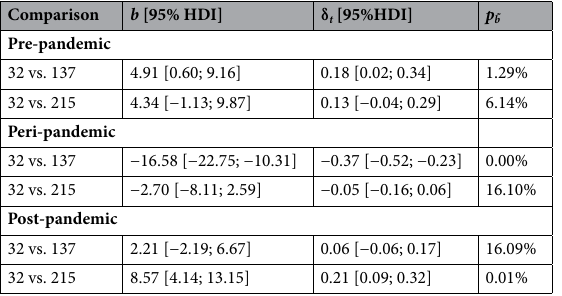
Table 1. Parameters of the Bayesian t -tests for the comparisons between the two follow-up dates and day 32, separate for each IPD measure; day 137 with N = 66 and day 215 with N =